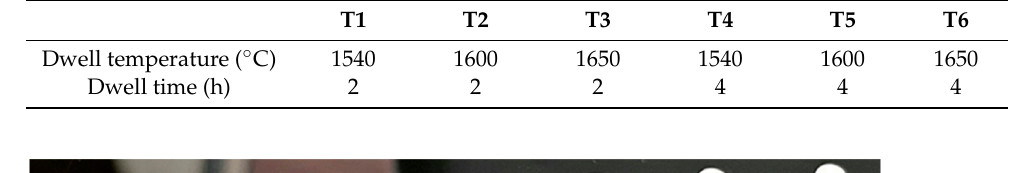
Table 2. Sets of sintering experiments performed.